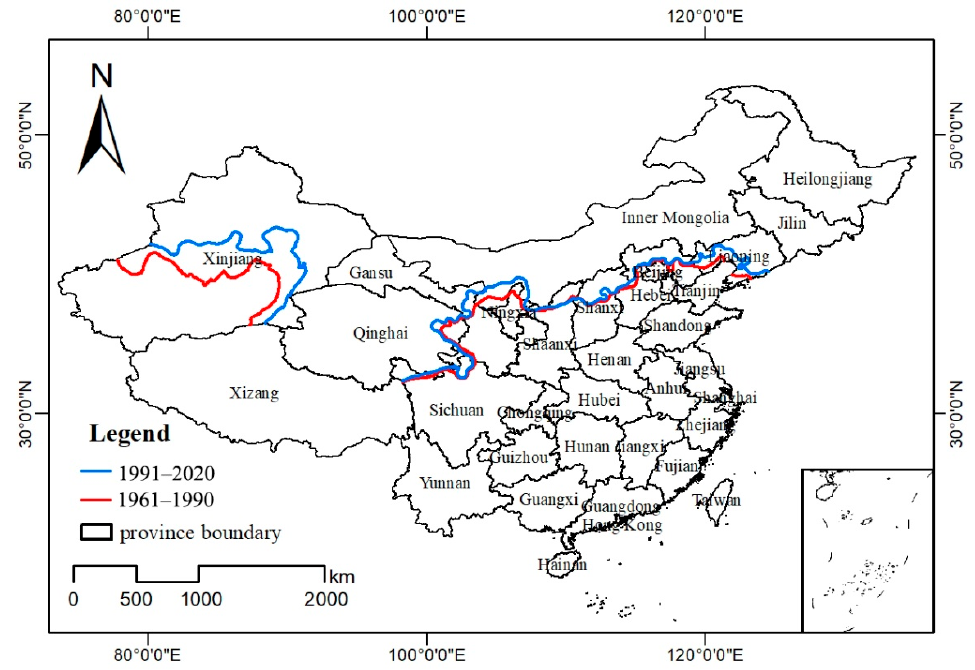
Figure 8. Potential northern planting boundary of winter wheat during the periods of 1961–1990 (red line) and 1991–2020 (blue line).